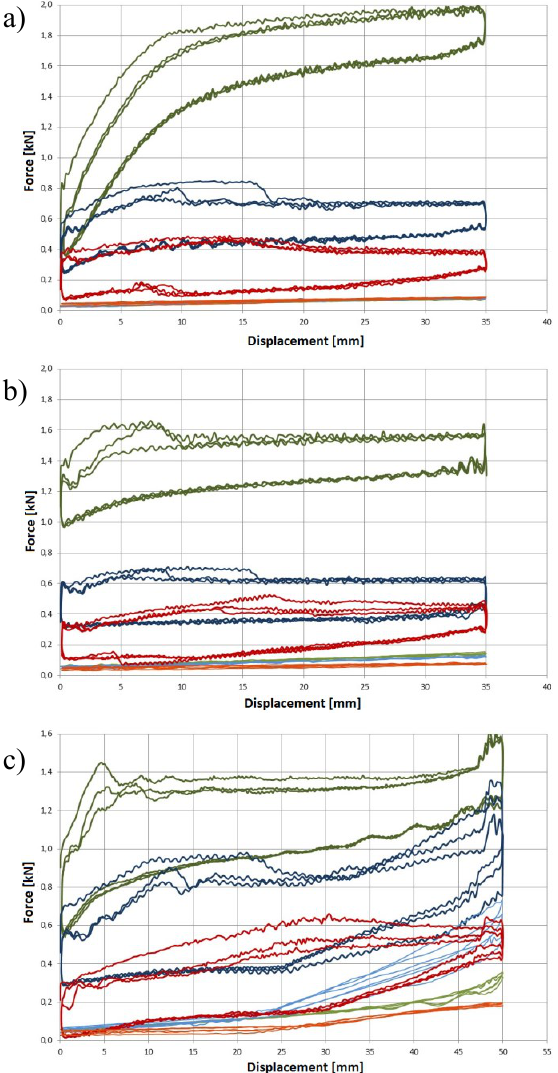
Fig. 4 . Experimental measurement of the forces of loaded prototype: bore width a) 550 mm, b) 650 mm, c) 750 mm.